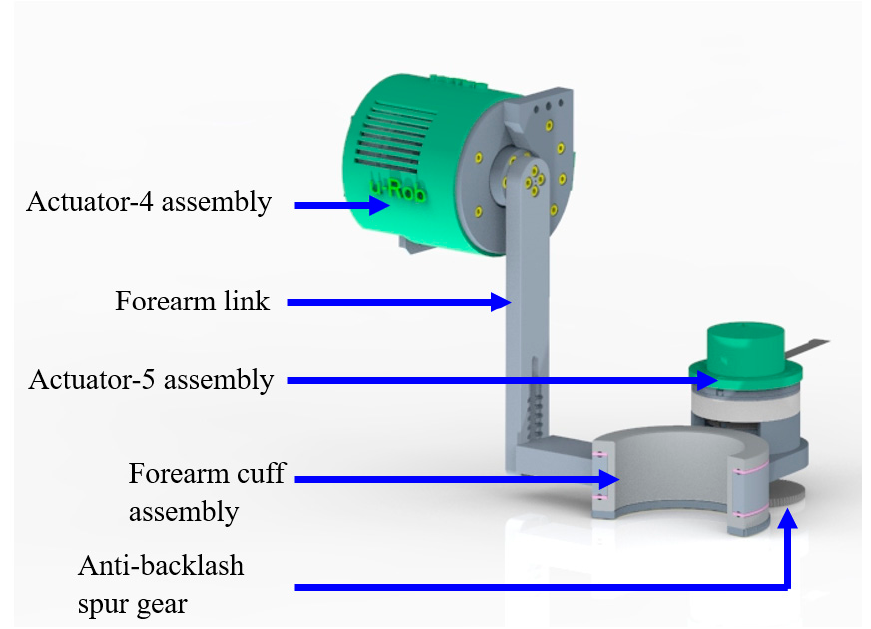
Figure 9. Elbow and forearm motion support part.